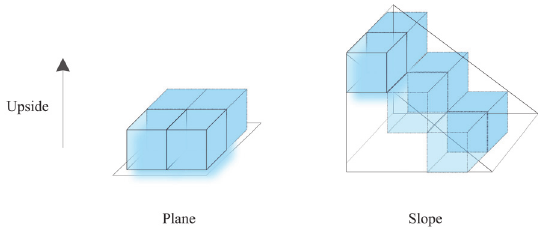
Figure 3. Evacuation area represented by regular accessible 3D